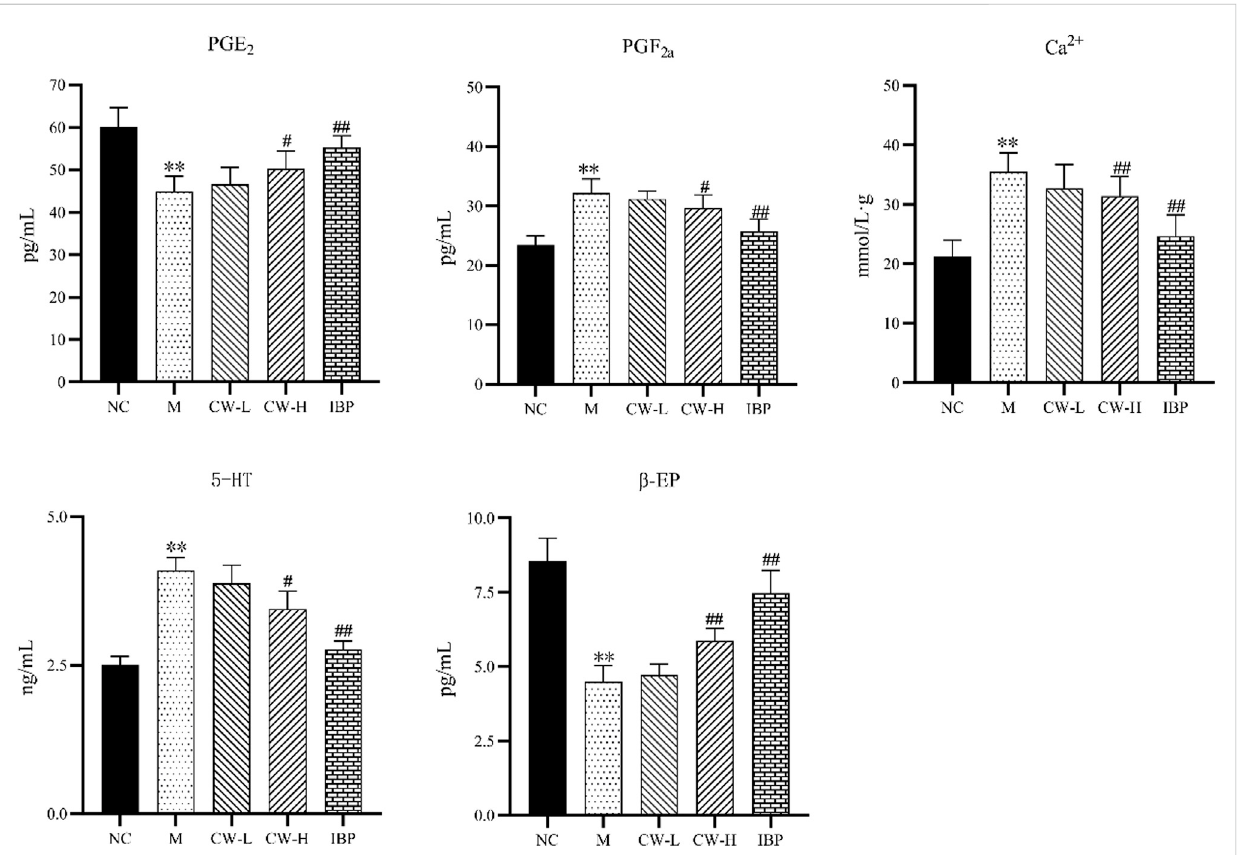
FIGURE 3 The results of biochemical indexes of rats in each group ( ‾ x ± s, n = 8). Compared with the NC group, * p < 0.05, ** p < 0.01; compared with the M group, # p < 0.05, ## p < 0.01. NC, Normal control group; M, Model group; CW-L, CW low-dose group; CW-H, CW high-dose group; IBP, Ibuprofen positive control